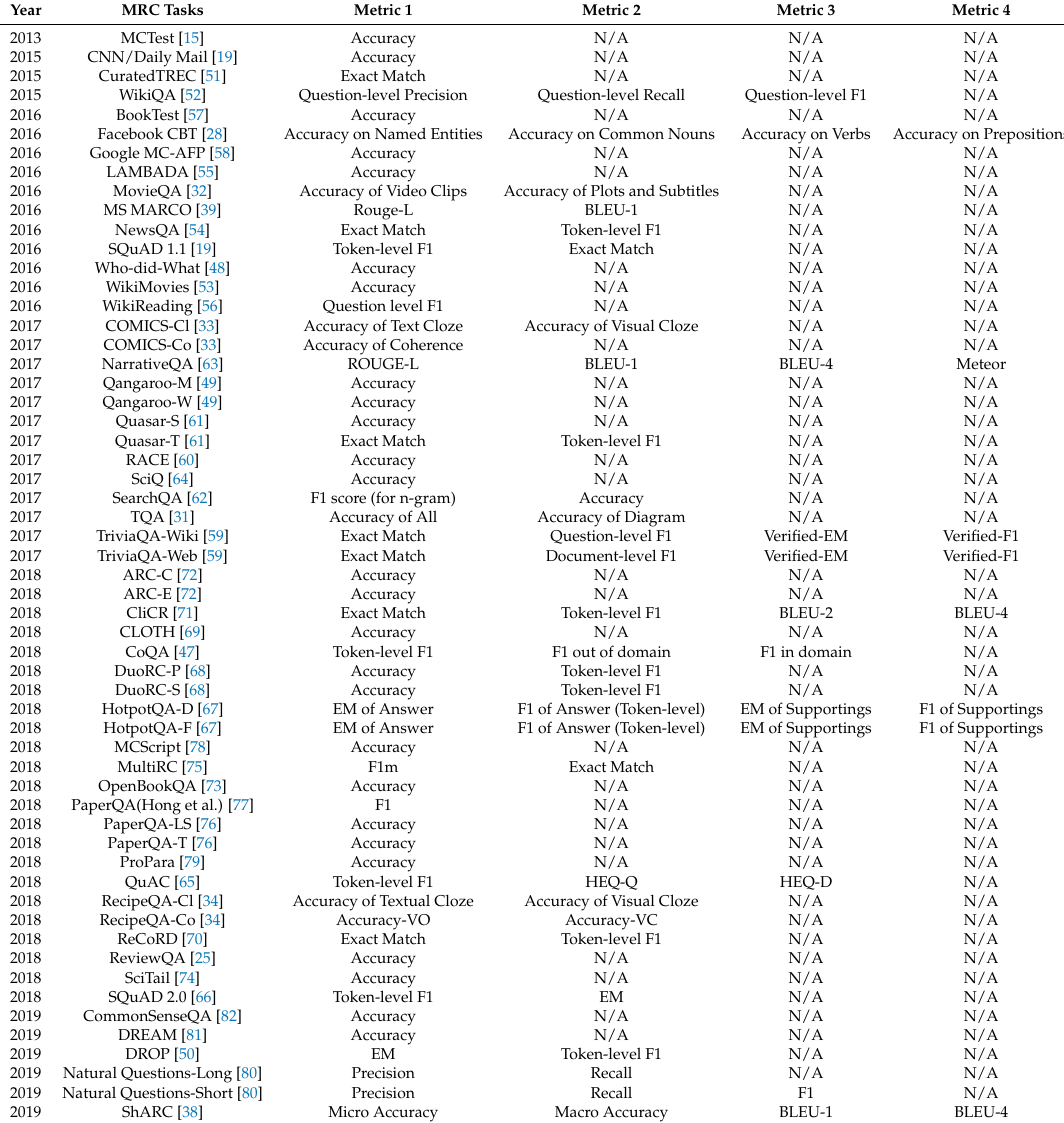
Table 2. Evaluation metrics of different machine reading comprehension tasks.